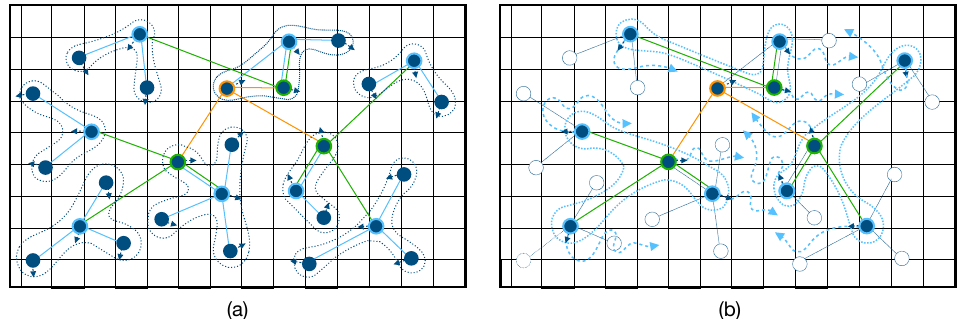
Figure 6: Cluster-based routing. (a) Clusters are groups of agents that share relatively stable Figure 6. Hierarchical multi-level clustering. ( a ) 3-level hierarchical tree where blue = level 1, communication channels. The metric for stability usually involves some weighted combination of green = level 2, and orange = level 3. Every level 2 and level 3 cluster-head belongs to a level 1 cluster. distance and velocity. Agents elect a cluster-head to coordinate intra-cluster communication. Cluster- ( b ) Ideally, higher-level clusters are more stable and tolerate drift over longer heads also act as gateways to the rest of the network. (b) Macro-clusters are groups of cluster-heads that also share stable communication channels. These “higher-level” clusters define stability over longer time-horizons. The clustering process continues until the system of agents is fully connected through a single communication tree.